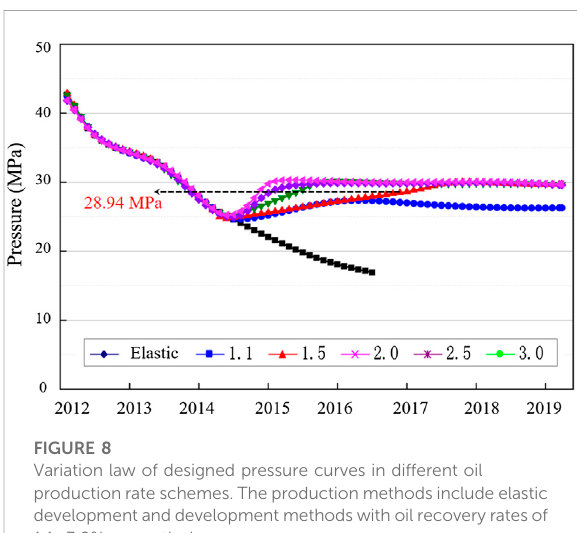
FIGURE 8 Variation law of designed pressure curves in different oil productionrate schemes. The production methods include elastic developmentand development methods with oil recovery rates of 1.1 – 3.0%